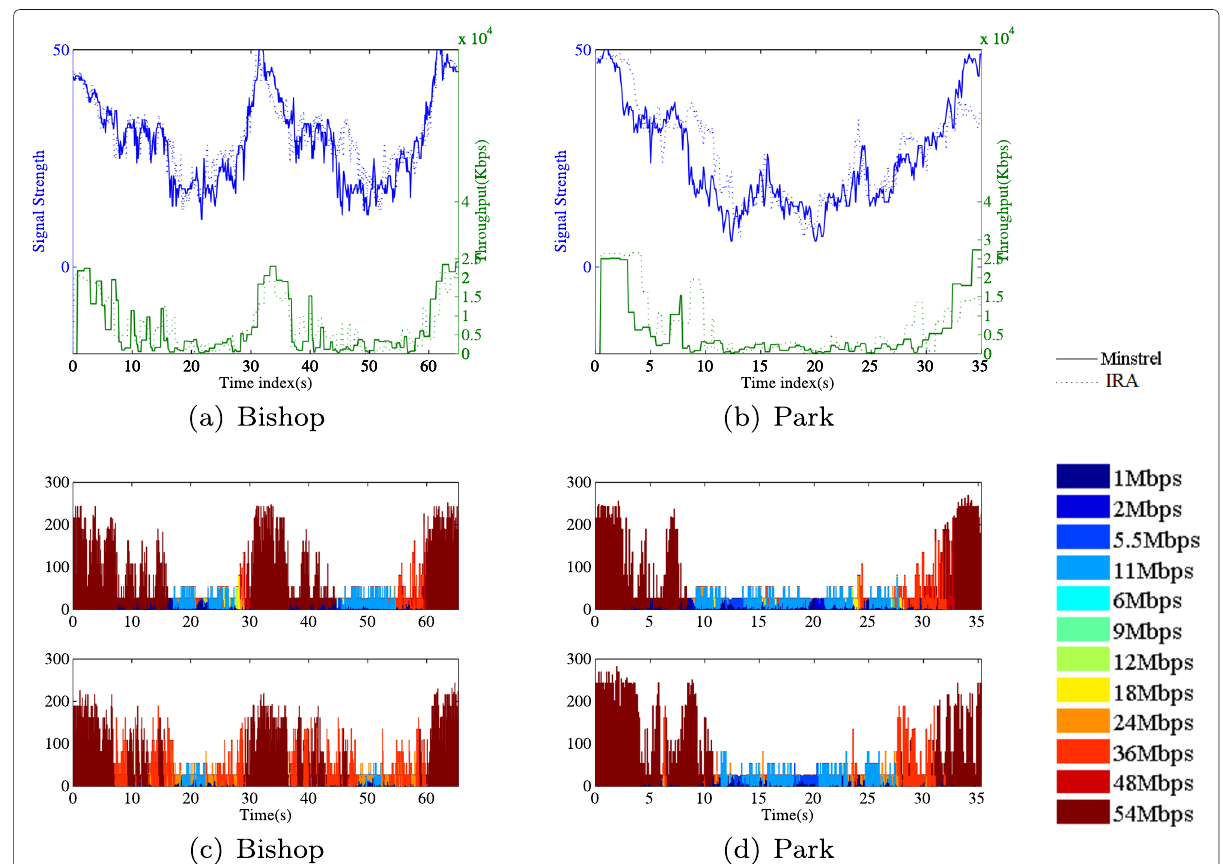
Fig. 12 In-field signal strength, throughput, and rate selection comparison. The rate selection performance is analyzed in in-field